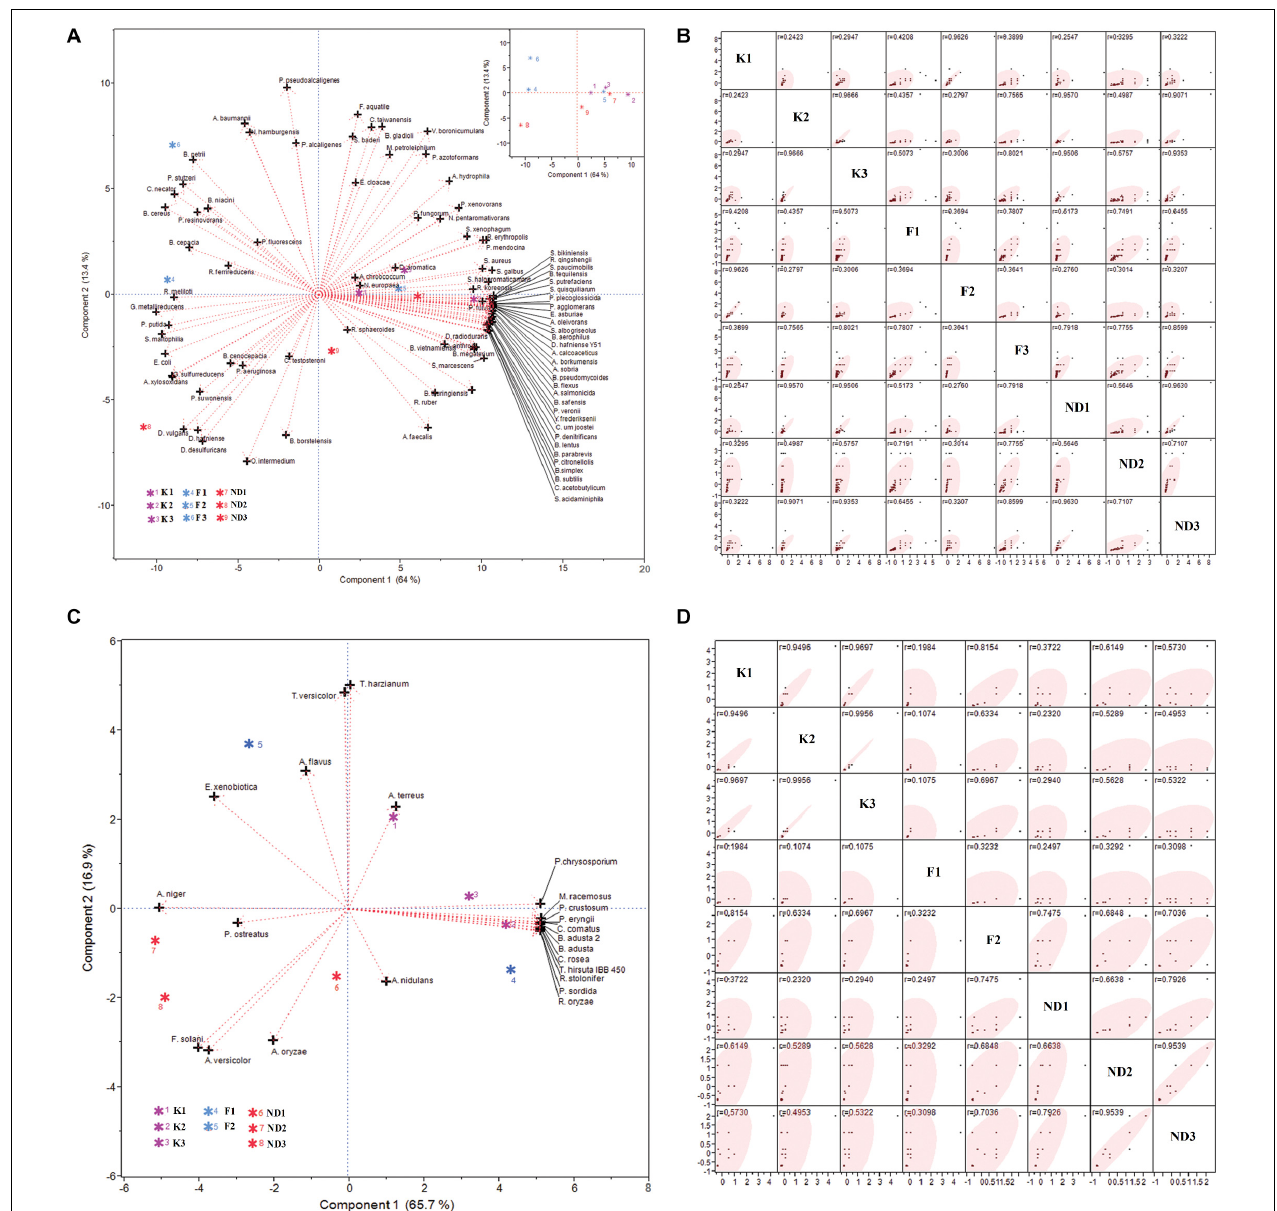
FIGURE 4 | PCA biplot and Scatter Plot Matirx of relative abundance of bioremediation bacteria ( A and B , respectively) and fungi ( C and D , respectively) found at the test sites. PC1 and PC2 together could explain 77.4% and 82.6% of variability in relative abundance of bacteria and fungi,